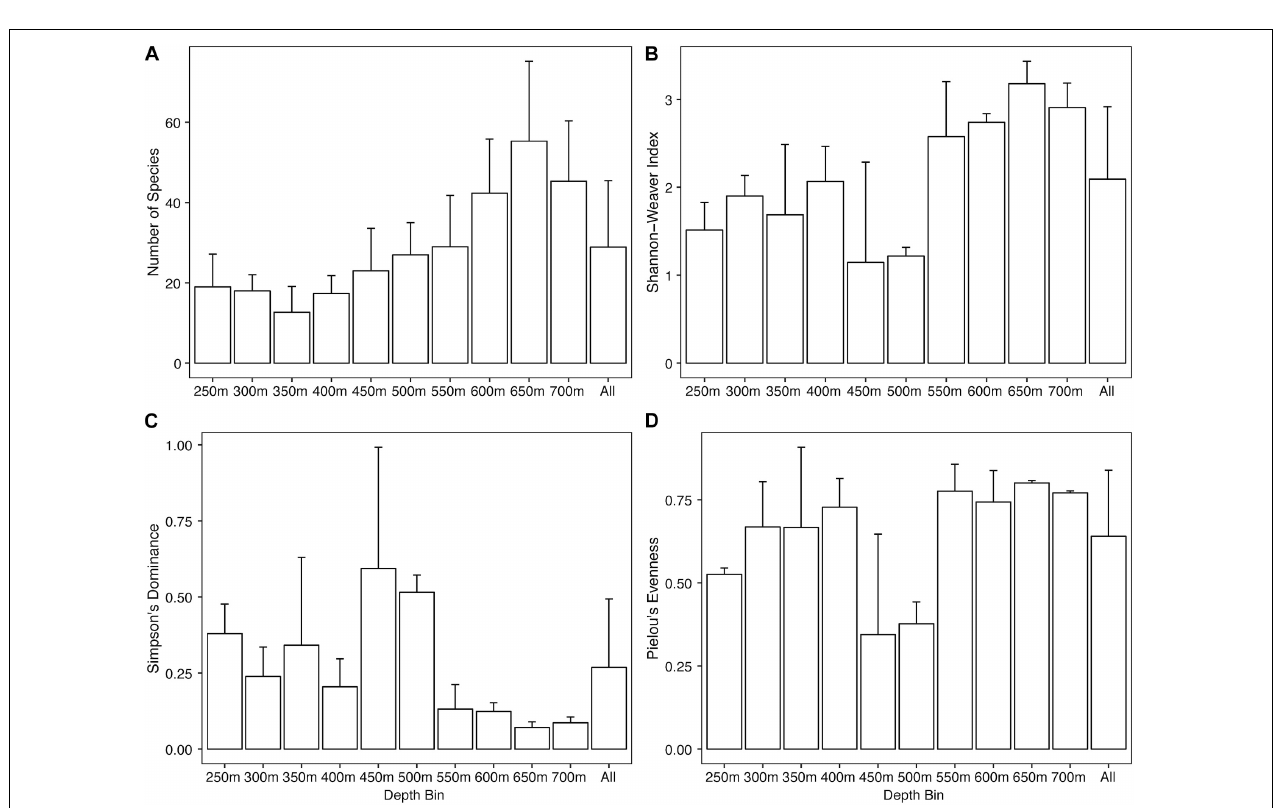
FIGURE 3 | Bar plots of univariate diversity metrics for the North side of Mokumanamana by depth. Panels: (A) species richness, (B) Shannon-Weaver’s Index, (C) Simpson’s Dominance Index, (D) Pielou’s Evenness Index.